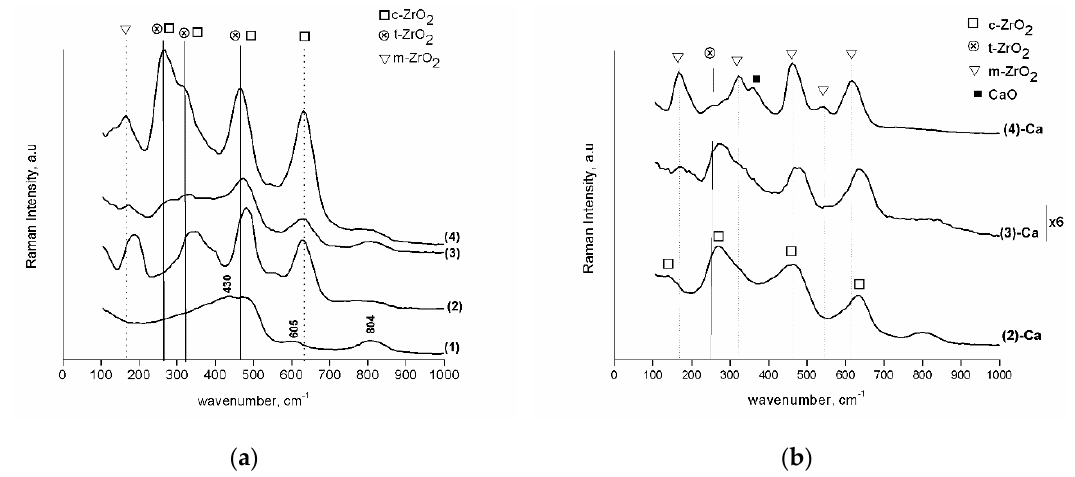
Figure 10. Raman spectra: ( a ) SiO 2 sphere (1), SiO 2 @ZrO 2 0.04M (2), SiO 2 @ZrO 2 0.06M, and (3) and SiO 2 @ZrO 2 0.08M (4) calcined at 700°C, ( b ) SiO 2 @ZrO 2 0.04M–CaO, (2)-Ca, SiO 2 @ZrO 2 0.06M–CaO, (3)-Ca and SiO 2 @ZrO 2 0.08M–CaO, (4)-Ca.